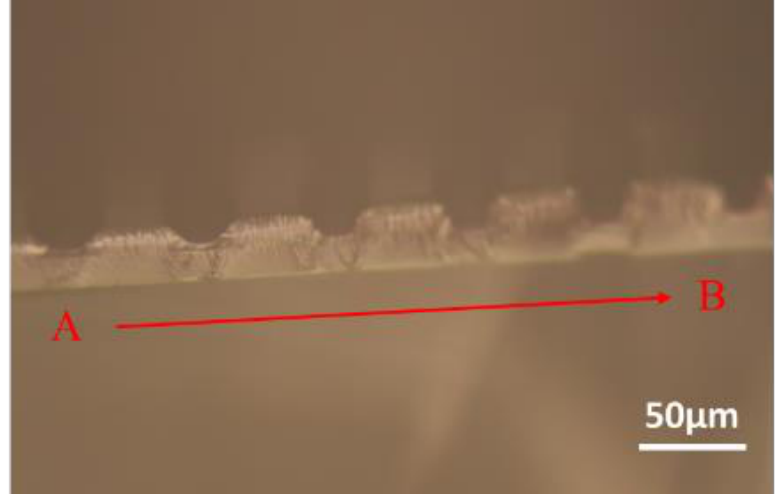
Figure 5. The OM image of the cross-section of the first layer of SU-8 photoresist.